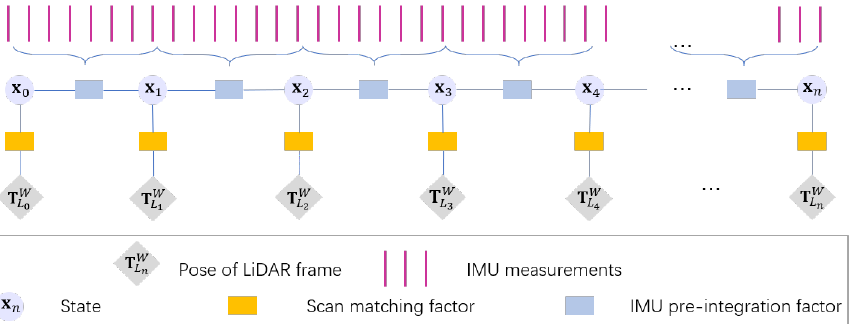
Figure 2. Factor graph of the proposed LC-LIO. The light purple circle represents the state of the IMU frame. There are two types of factors introduced to constrain the states, namely the scan match- ing factor and IMU pre-integration factor.